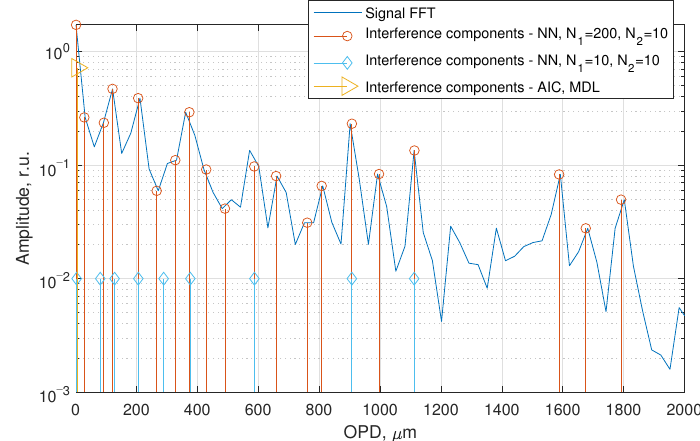
Figure 6. Fourier transform of the spectral interference signal shown in Figure 5 (with perturbations S = 0 m (cid:101) , C = 0.04 m − 1 ) with interference components identified using the proposed ML approach and both AIC and MDL